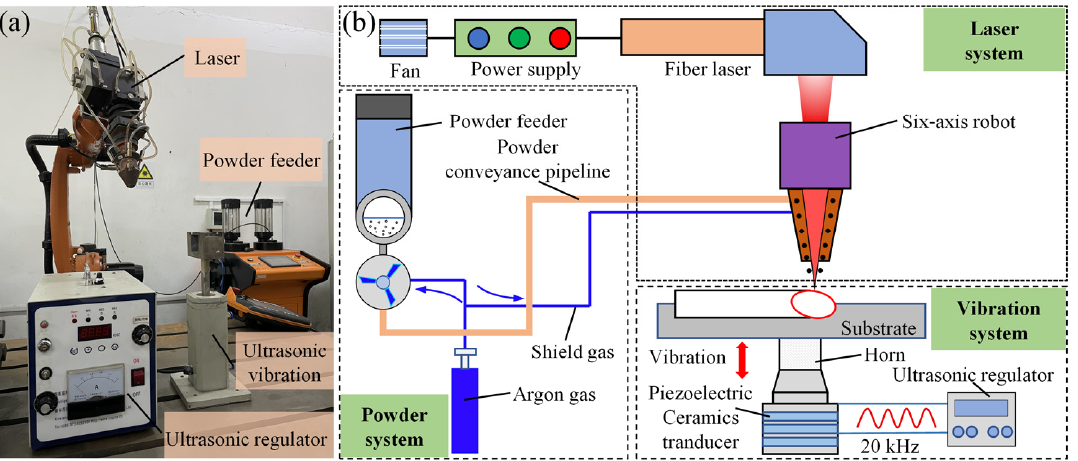
Figure 2. Setup for laser cladding with ultrasonic assistance. ( a ) Overall layout diagram; ( b ) schematic diagram of ultrasonic-assisted laser cladding processing system.